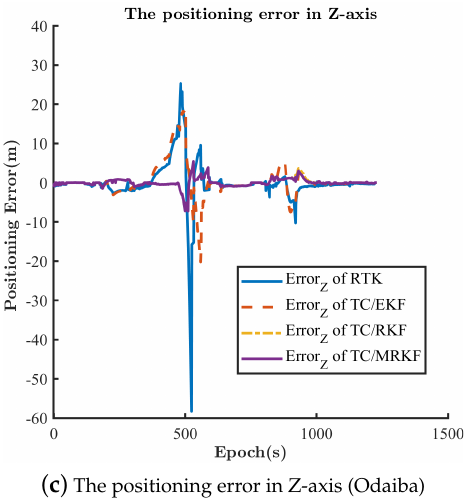
Figure 19. The positioning error in three dimensions (Odaiba).